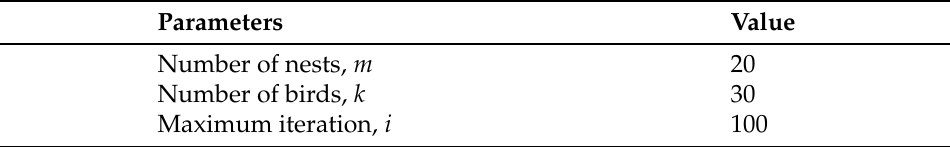
Table 4. CS setup